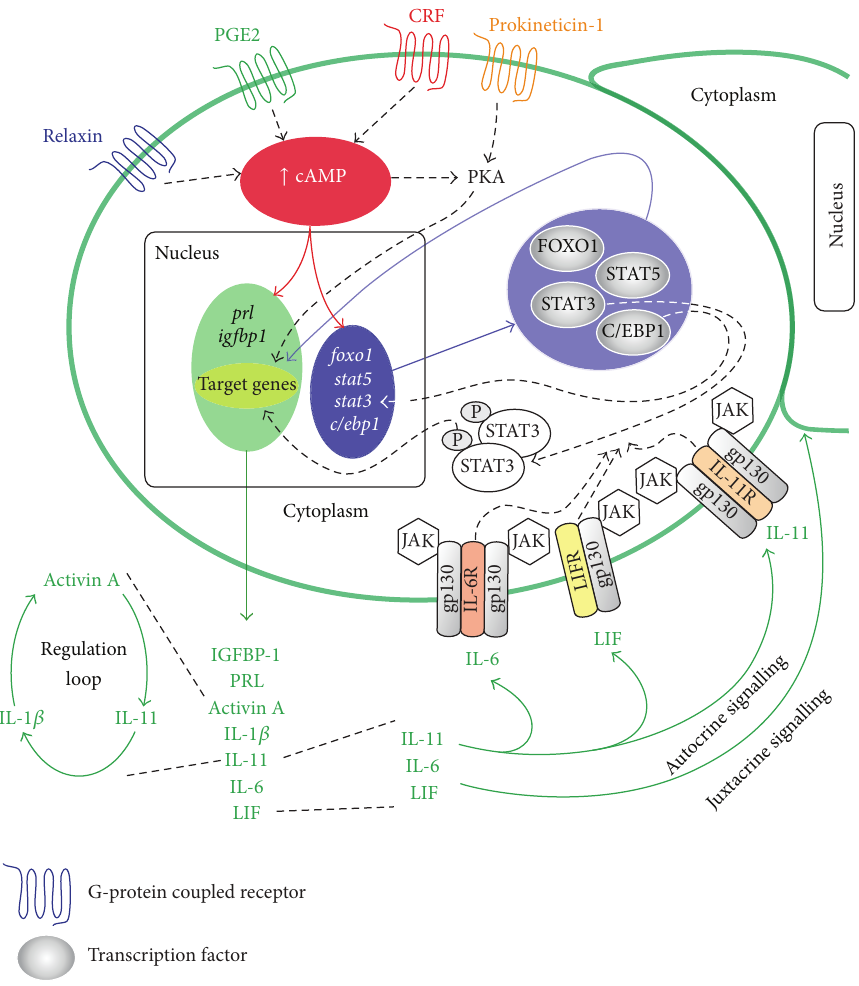
Figure 2: Targets of cAMP signalling during